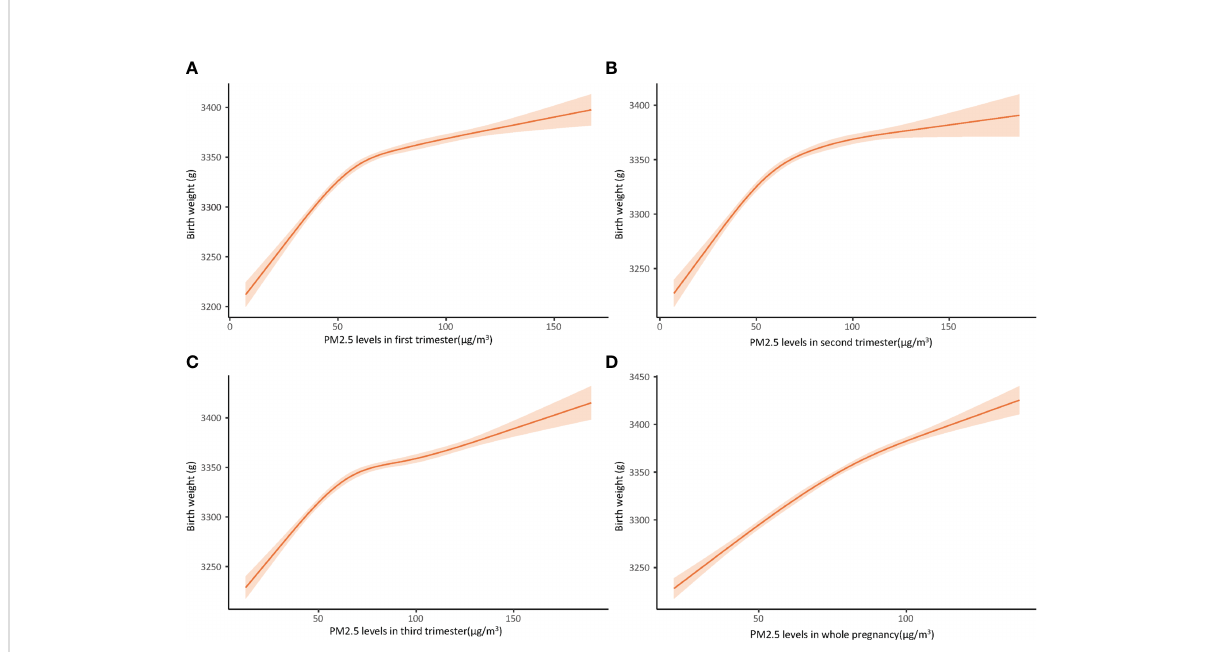
FIGURE 2 Dose-response relationship between PM 2.5 concentration and birth weight in fi rst trimester (A) , second trimester (B) , third trimester (C) , and whole pregnancy (D) , using cubic restricted model, adjusted for maternal age at delivery, neonatal sex, smoking during pregnancy, drinking during pregnancy, gestational week, pre-pregnancy BMI, educational level, prolonged pregnancy, multiparity, pre-pregnancy diabetes mellitus, pre-pregnancy hypertension,